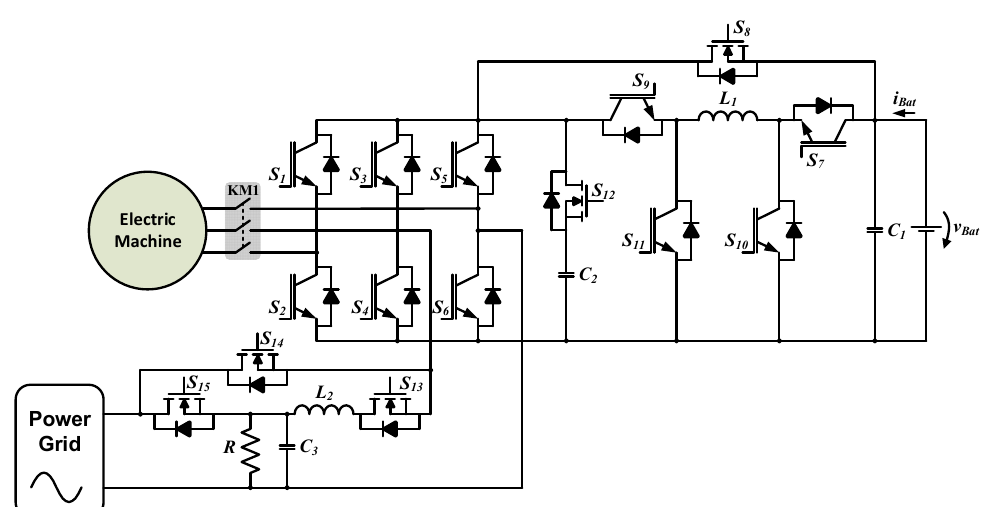
Figure 2. Non-isolated, single-phase unified power converter topology based on the disconnection of the electric machine from the power converter [27].